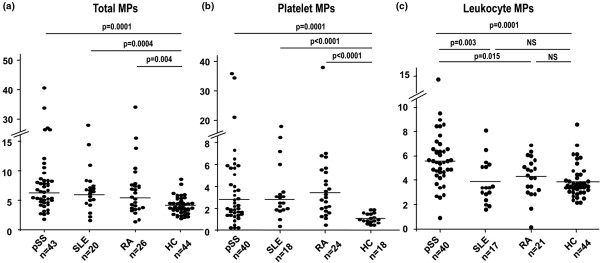
Plasma level of circulating microparticles. (a) Total microparticles (MPs); (b) platelet-derived MPs; (c) leukocyte-derived MPs in patients with primary Sjögren's syndrome (pSS), systemic lupus erythematosus (SLE), rheumatoid arthritis (RA) and healthy controls (HCs) by solid-phase capture with functional prothrombinase assay. Results are expressed as nM PS Eq. Horizontal lines show the mean value. Differences between groups were analyzed by the Mann-Whitney U test. All comparisons not specified in the figure were not significant (NS).